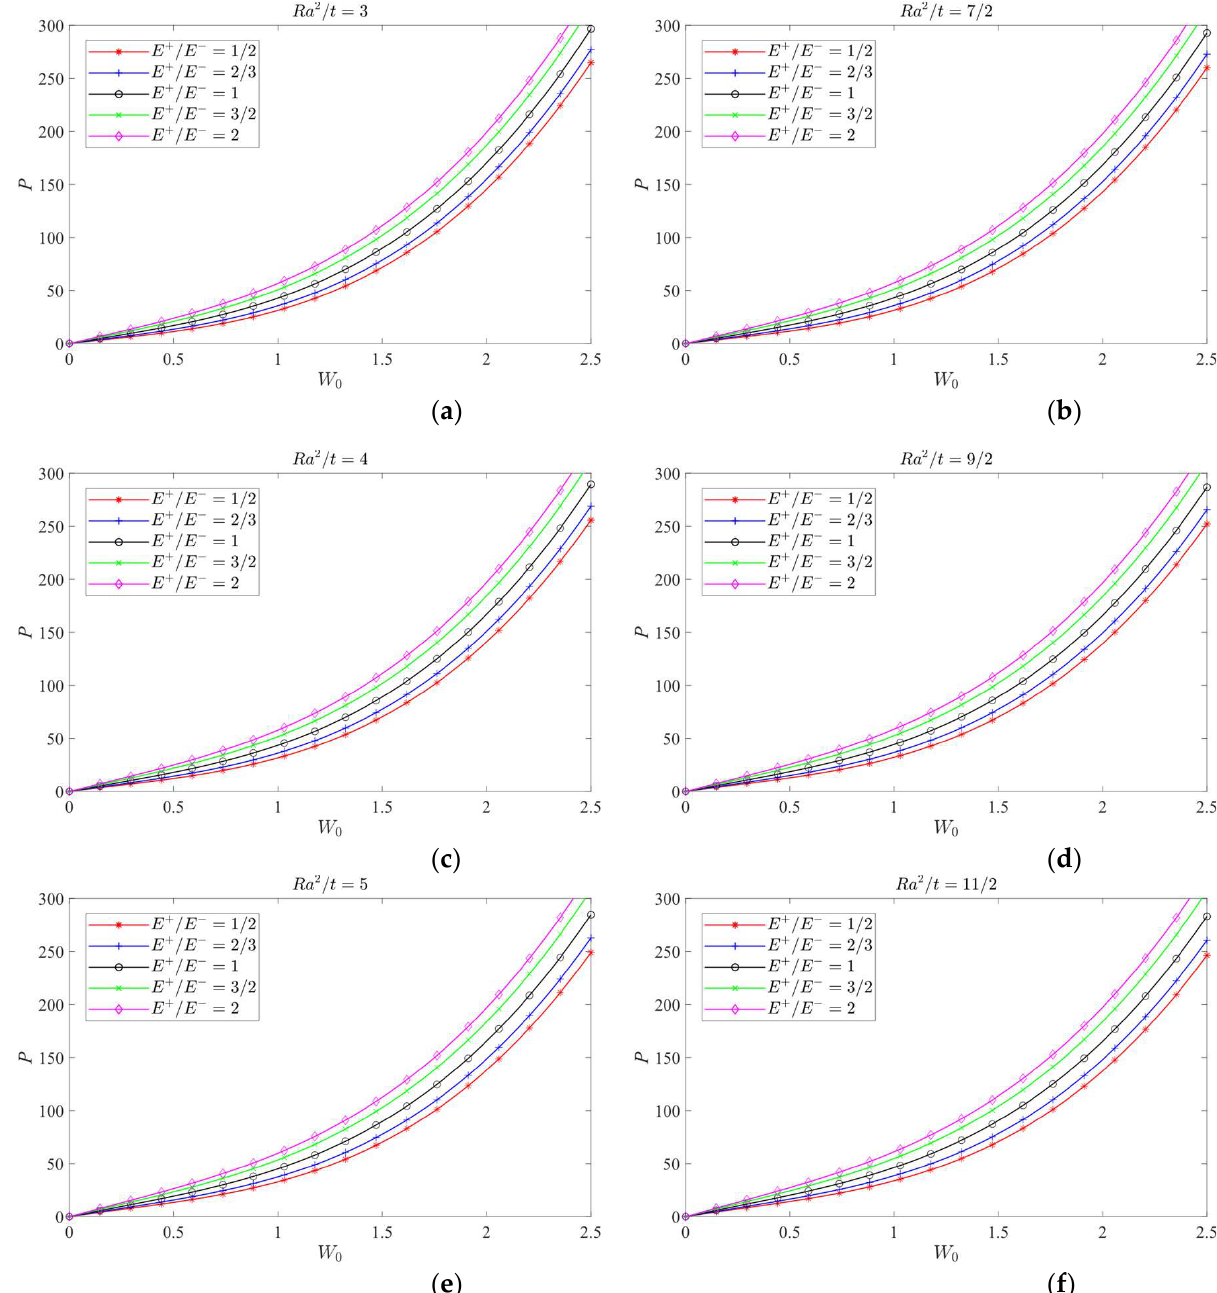
Figure 12. Load vs. central deflection when λ = 1. ( a ) Ra 2 / t = 3; ( b ) Ra 2 / t = 7/2; ( c ) Ra 2 / t = 4; ( d ) Ra 2 / t = 9/2; ( e ) Ra 2 / t = 5; ( f ) Ra 2 / t = 11/2.